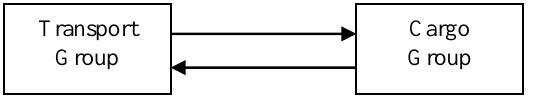
Fig. 1. Collaboration between two target groups.